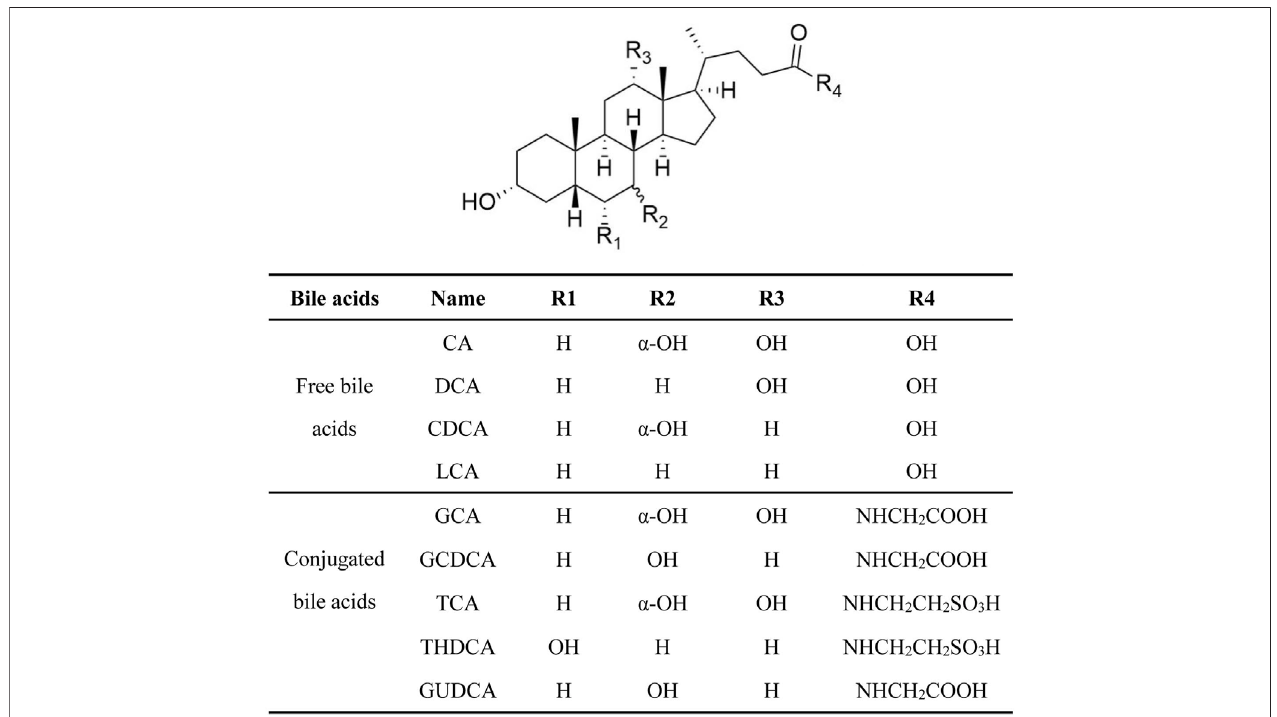
FIGURE 1 | The chemical structure and compositions of BA.